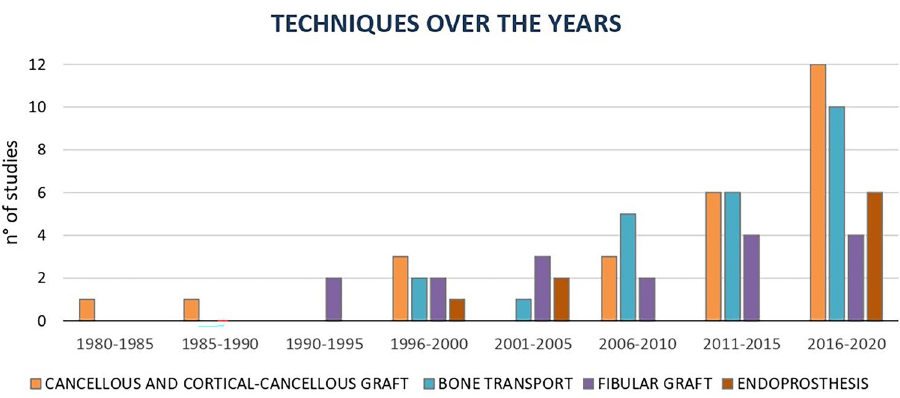
Figure 2. Graphic representation of the trend, over the years, of the four major groups of